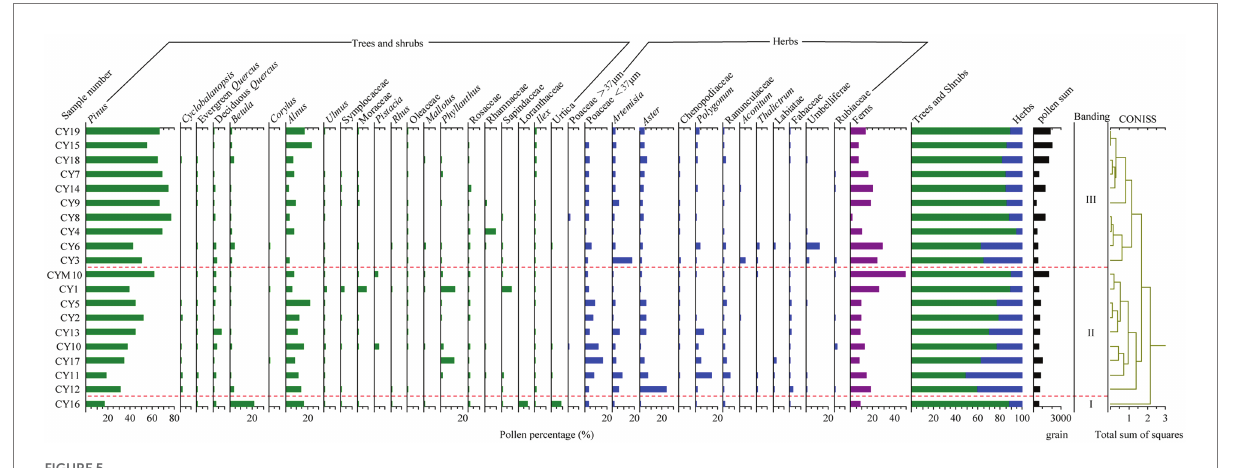
FIGURE 5 Chart of the percentage of topsoil pollen in the research